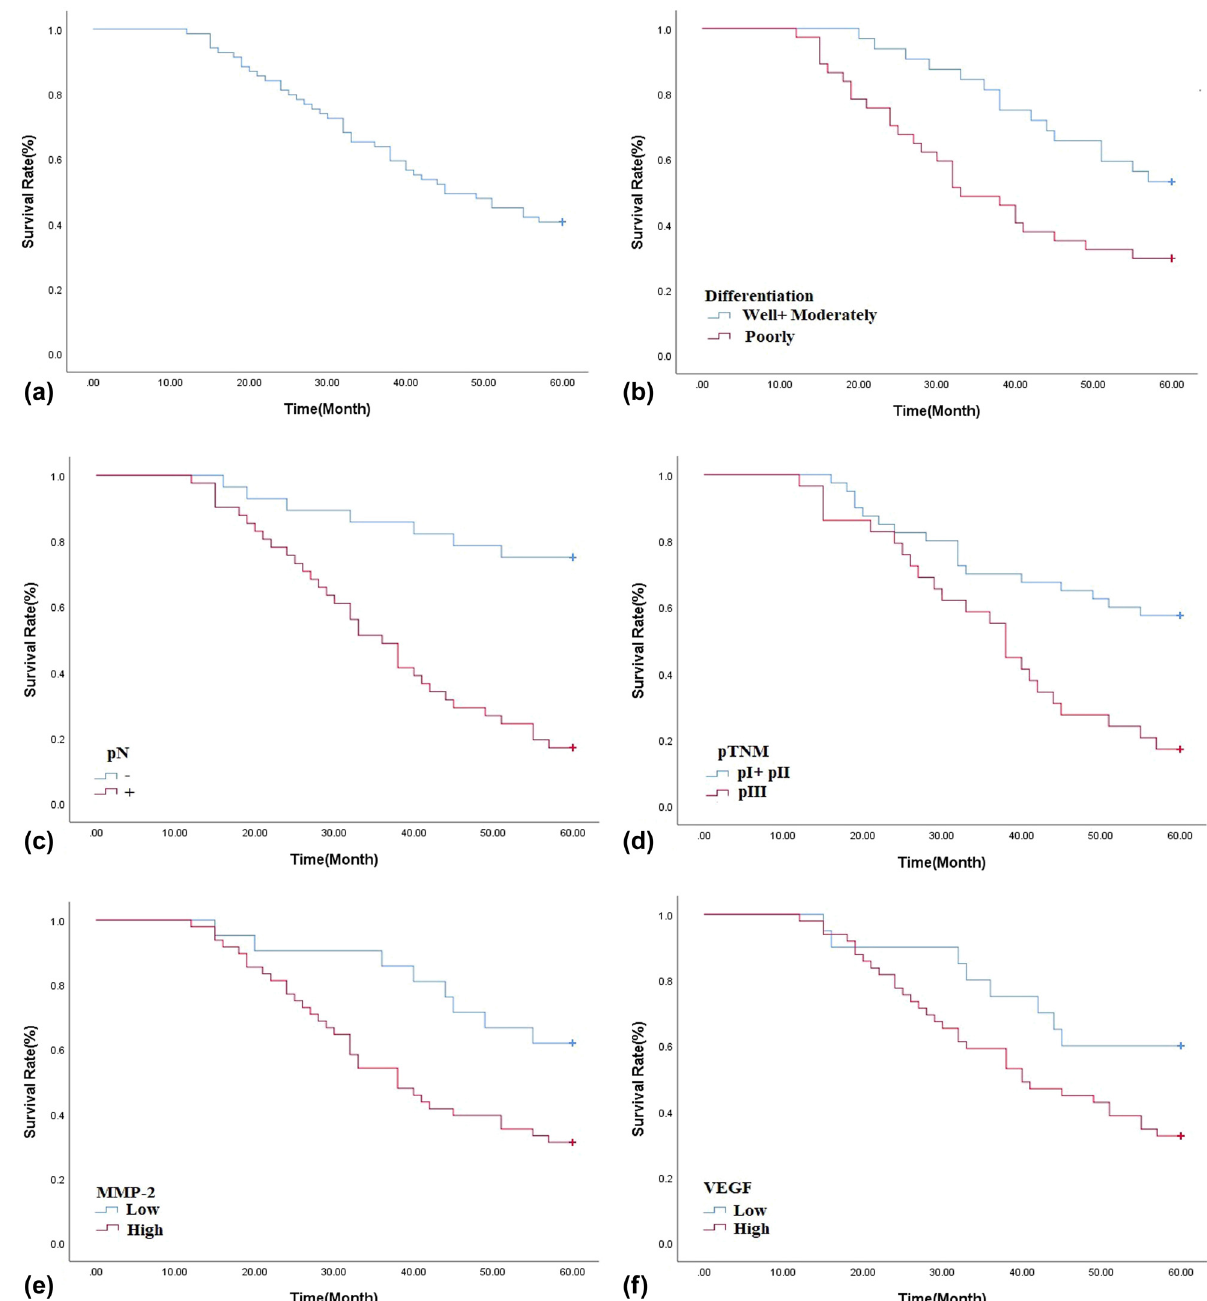
Figure 3: ( a ) The Kaplan - Meier survival curve of 69 cases of AEG patients. ( b ) Survival curves of AEG patients with tumor di ff erentiation. ( c ) Survival curves of AEG patients with negative or positive pN. ( d ) Survival curves of AEG patients with di ff erent pTNM. ( e ) Survival curves of AEG patients with low or high expression of MMP - 2 expression. ( f ) Survival curves of AEG patients with low or high expression of VEGF